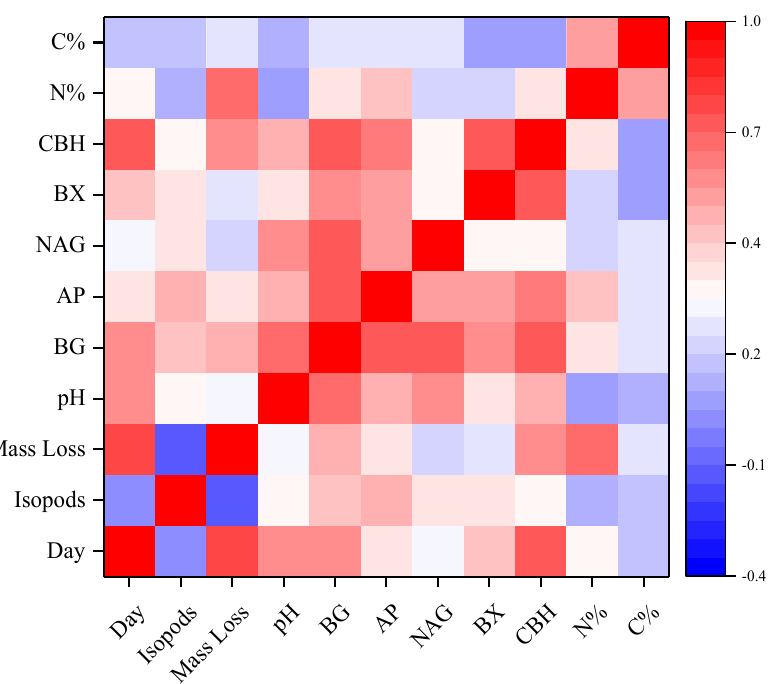
Figure 7. Heatmap of correlation analysis among factors. The color diagram on the right represents the level of correlation between factors.